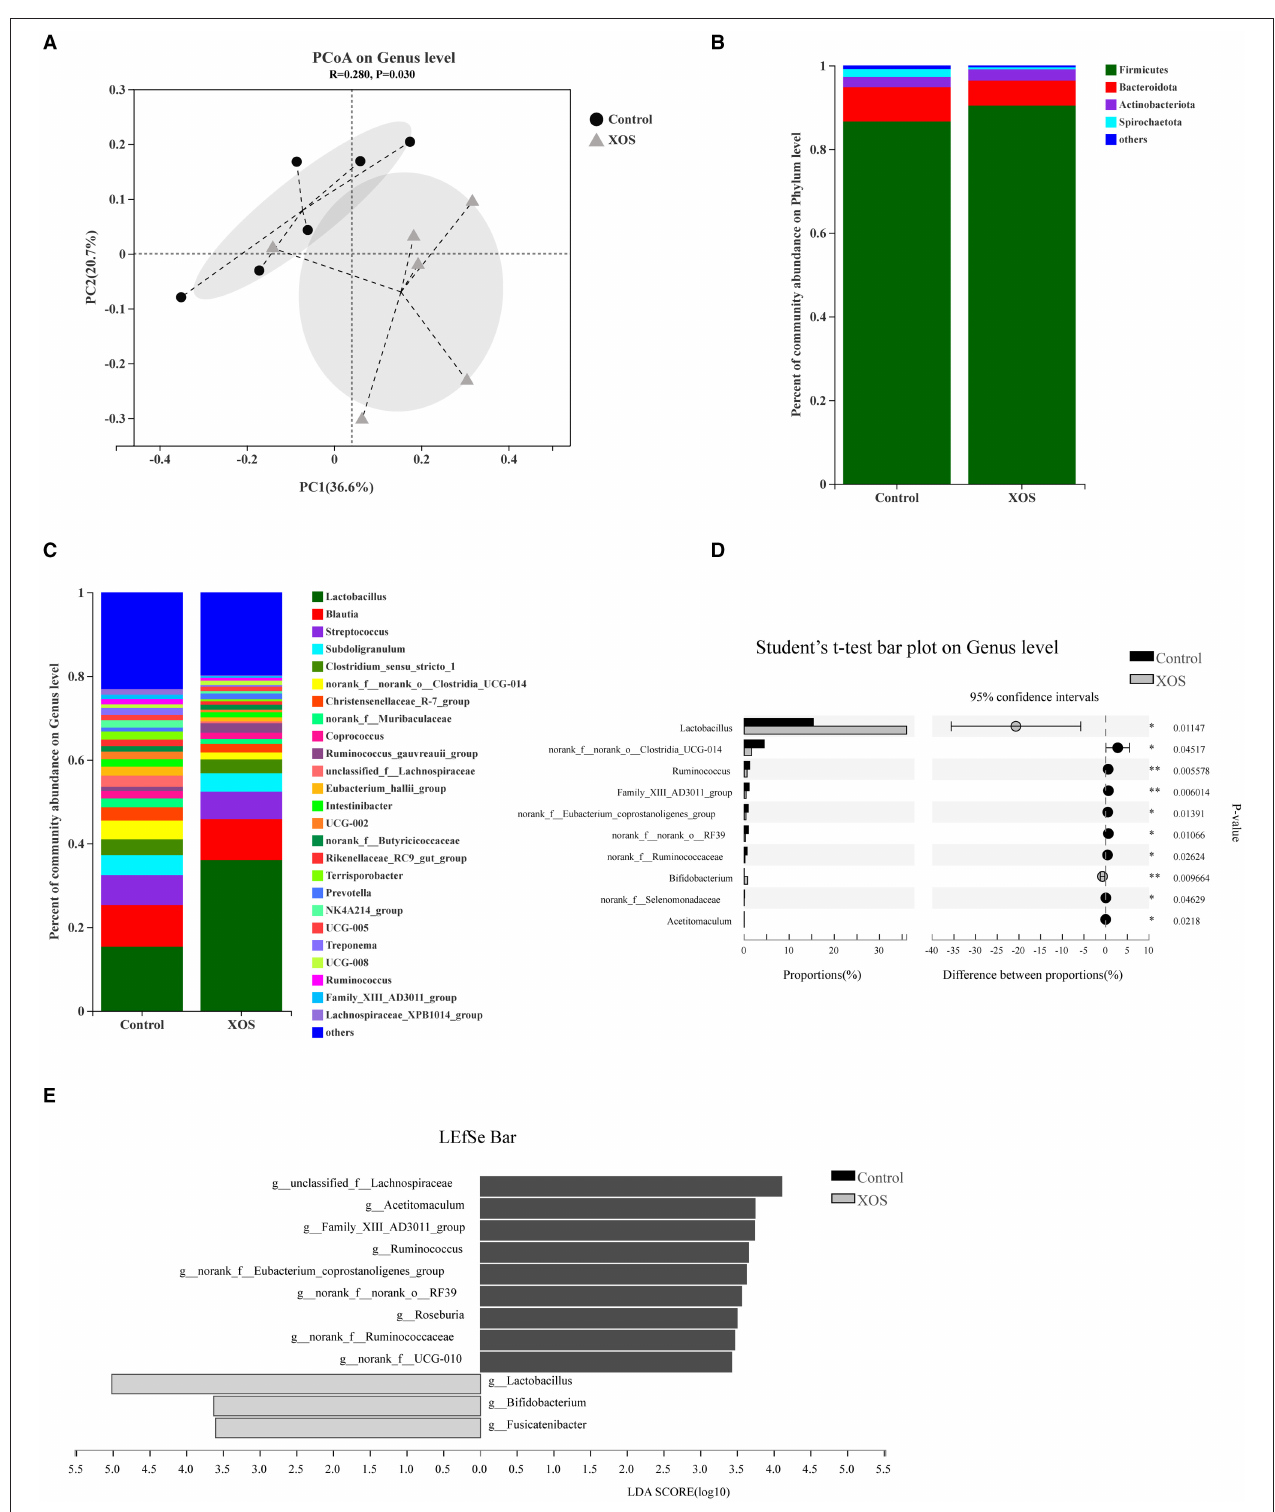
FIGURE 1 | Dietary supplementation with xylooligosaccharides (XOS) modulates the composition of fecal microbiota. (A) Principal coordinate analysis (PCoA) on genus level based on Bray-Curtis distances. Composition of bacterial communities (B) at the phylum level and (C) at the genus level. (D) Differential bacteria at the genus level. (E) Linear discriminant analysis (LDA) effect size (LEfSe) analysis screened biomarker of microbial community after addition of XOS. * P < 0.05 and ** P < 0.01, n = 6 for each group.